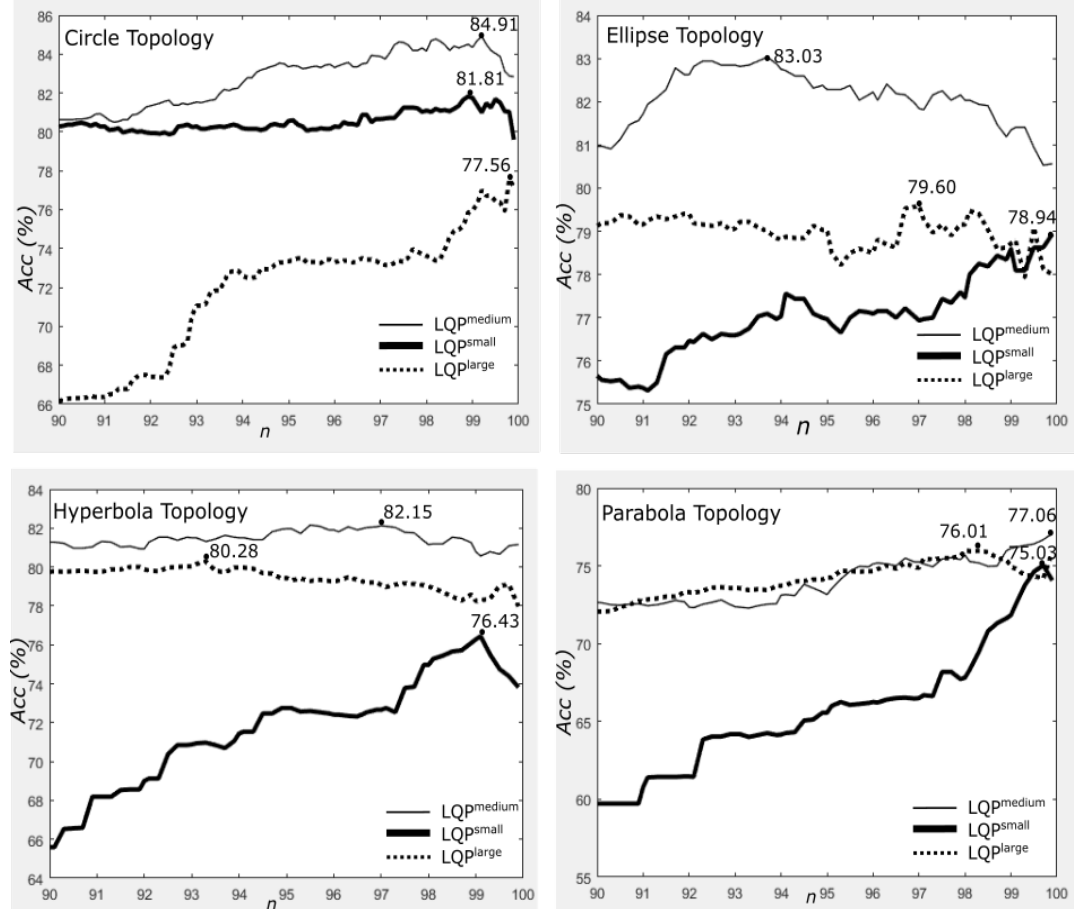
Figure 10. Quantitative results using different multiresolutions based on different neighbourhood topologies. Note that the x- axis and y- axis represent the accuracy (percentage of correctly classified cases) and the percentage of dominant patterns,